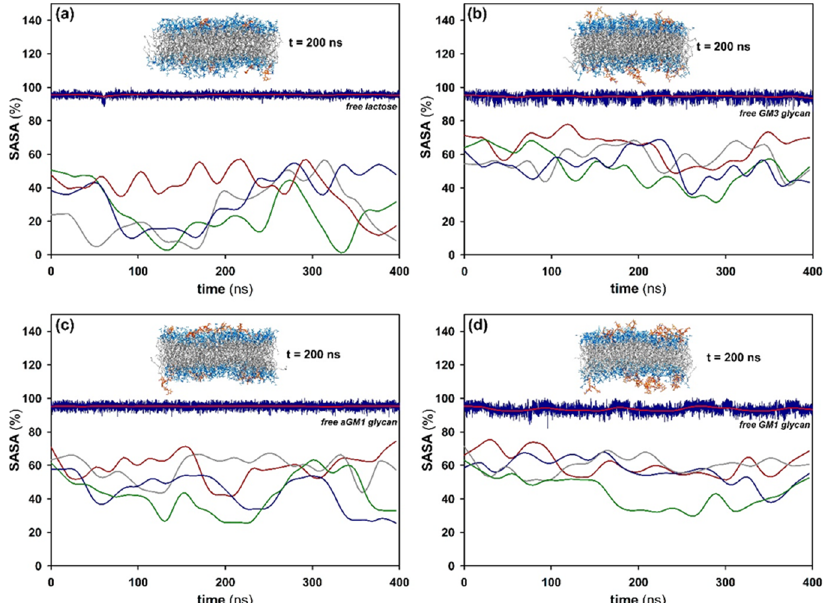
Figure 7. Solvent accessible surface area (SASA, %) along the simulation time referenced to free glycan moiety (straight line around 100% in all panels): ( a ) POPC:LacCer bilayer (system 2), reference: lactose; ( b ) POPC:GM3 bilayer (system 3), reference: 3 ′ SL; ( c ) POPC:aGM1 bilayer (system 4), reference: aGM1 tetrasaccharide; ( d ) POPC:GM1 bilayer (system 5), reference: GM1 pentasaccharide. Raw and smoothed SASA data are shown for each free glycan. The behavior of four randomly chosen sugar moieties in each case are followed during the time course of the simulation (graphs in the bottom part of the panels). Snapshots at 200 ns are displayed for each bilayer model at the upper part of the panel. Color code: glycan residues in orange; phosphocholine (PC) in blue; palmitoyl (PA), oleoyl (OL), and ceramide (CER) moieties in grey.